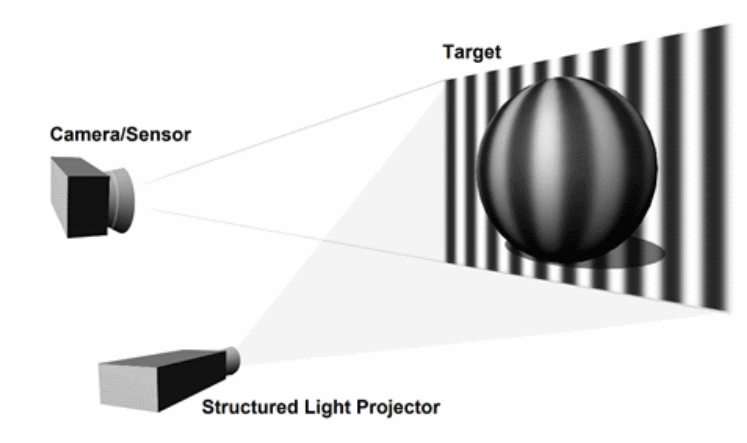
Figure 4. Structured-light technique diagram.